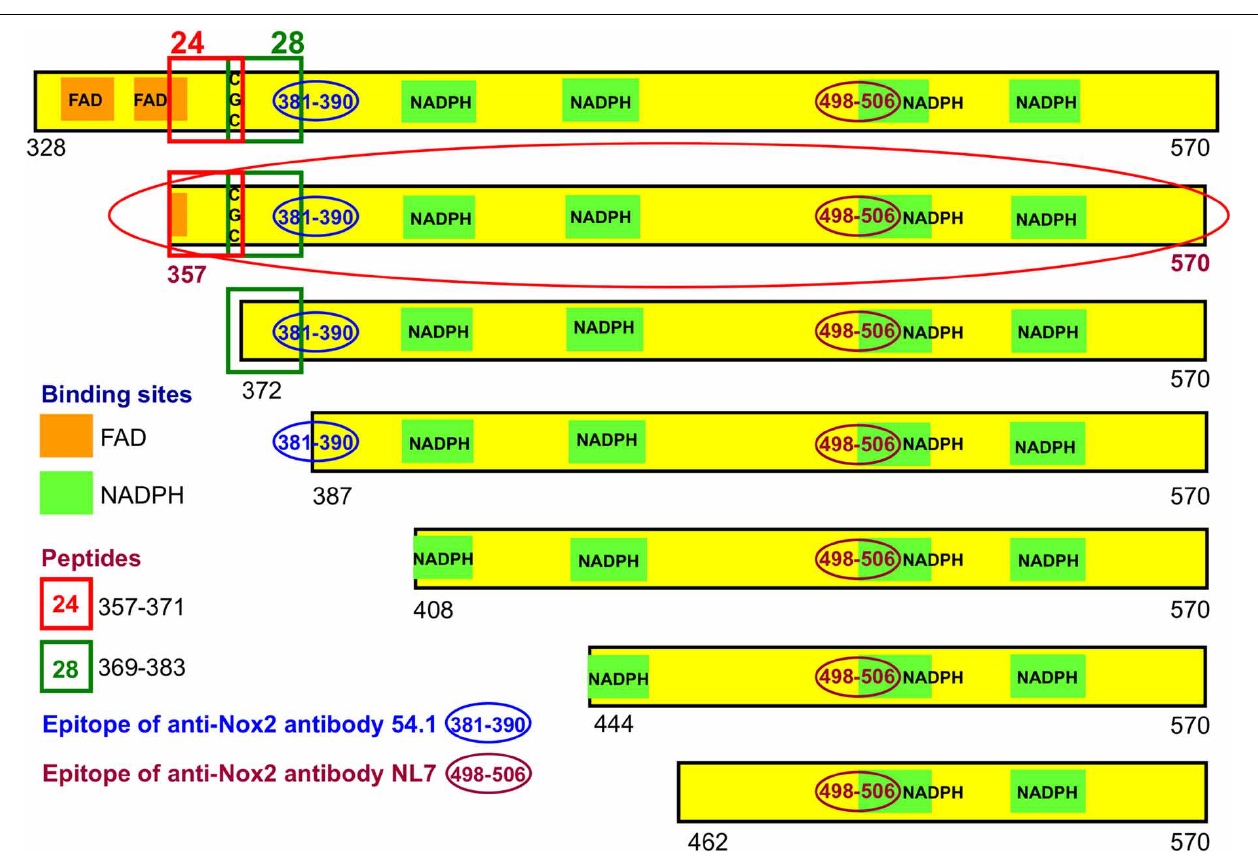
FIGURE 3 | Recombinant NusA-Nox2 proteins used in the present work. A number of NusA-Nox2 fusion proteins, consisting of NusA and segments of the dehydrogenase region of Nox2, were constructed (see Materials and Methods and Supplementary Material). The figure shows a schematic representation of the serial N-terminal truncations of the Nox2